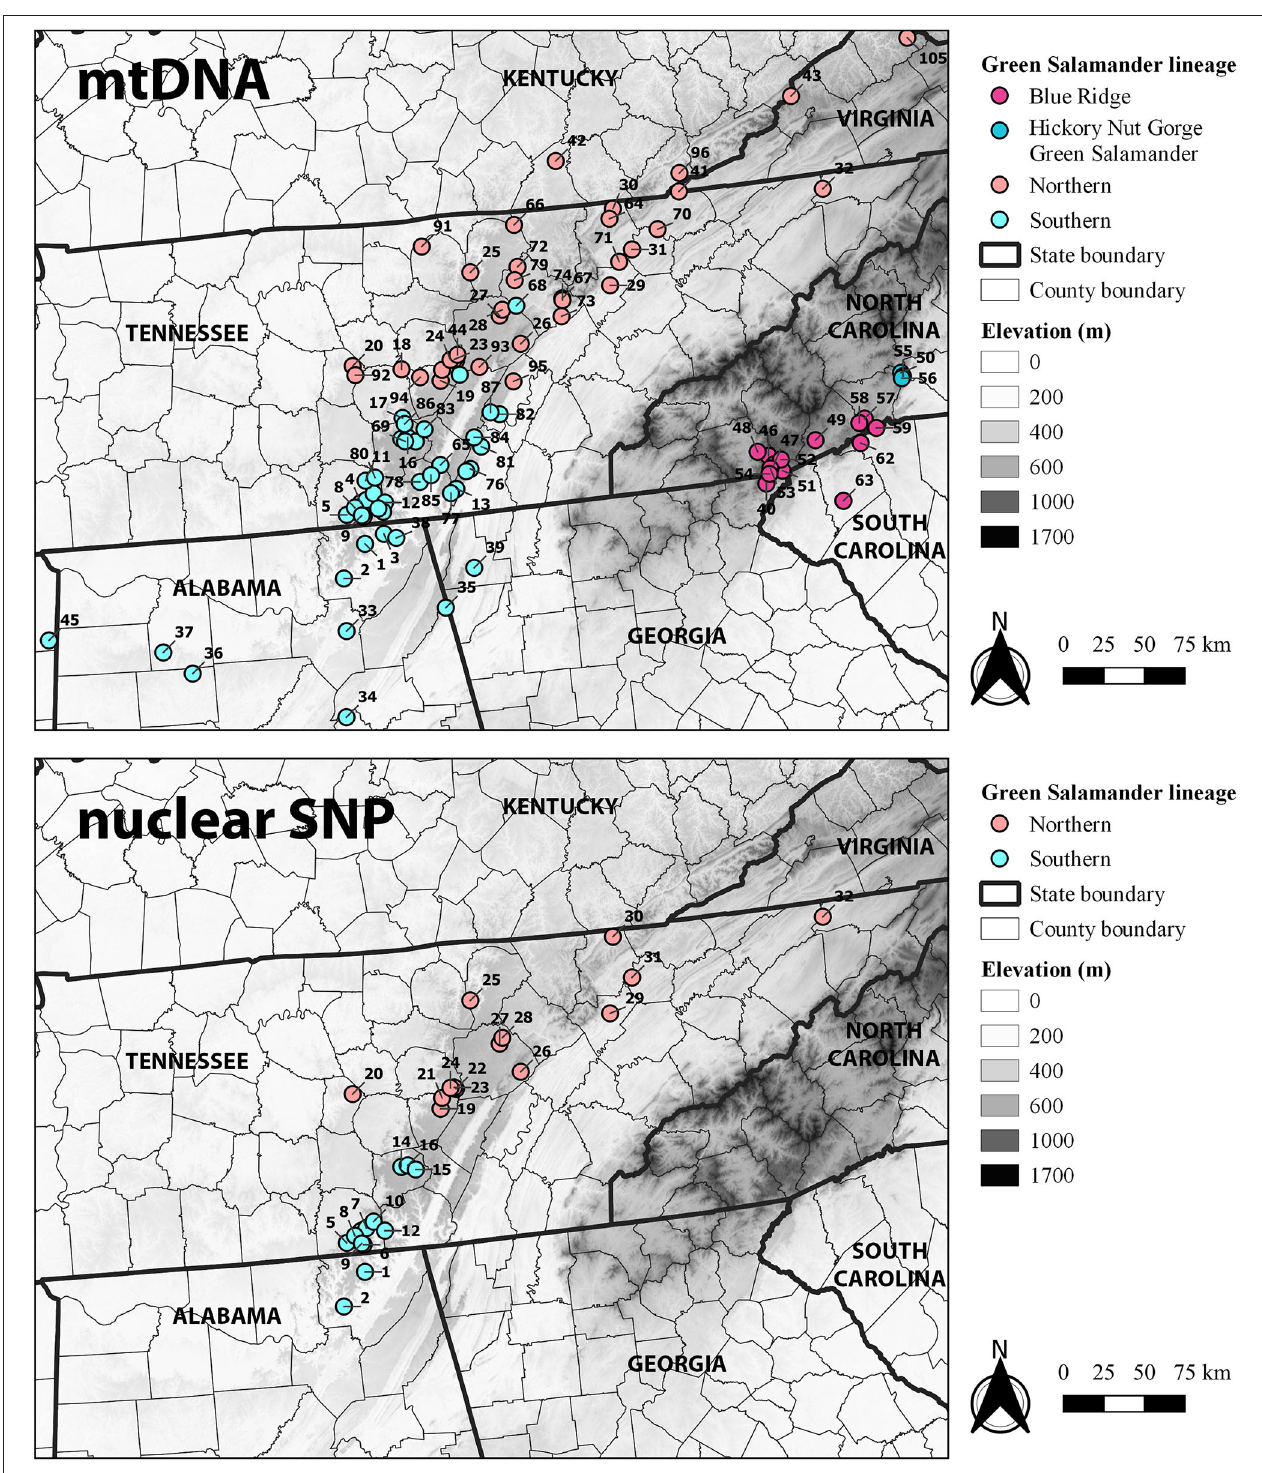
FIGURE 1 | Map showing sample sites by major mitochondrial lineage based on the cytb dataset (A) and by major lineage for fastStructure and IQ-TREE analyses of the nuclear SNP dataset (B) . Site numerical labels correspond to those in Table 1 ; Supplementary Table S1 . State labels are shown.